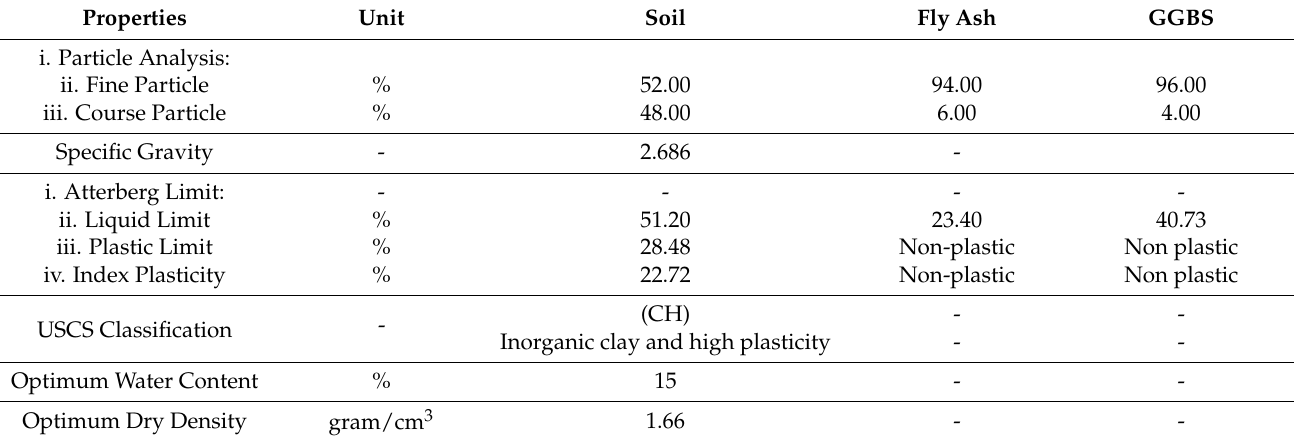
Table 2. Properties of clay soil, fly ash and ground granulated blast